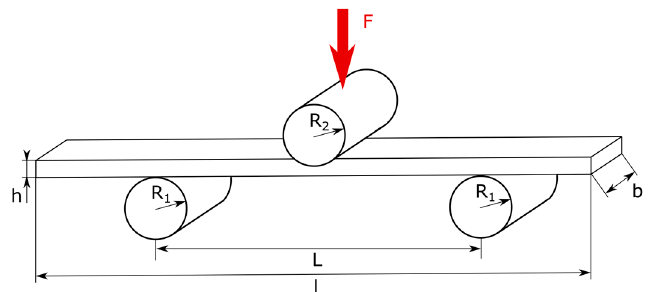
Figure 3. Three-point flexural test setup according to DIN EN ISO 14125 [19].